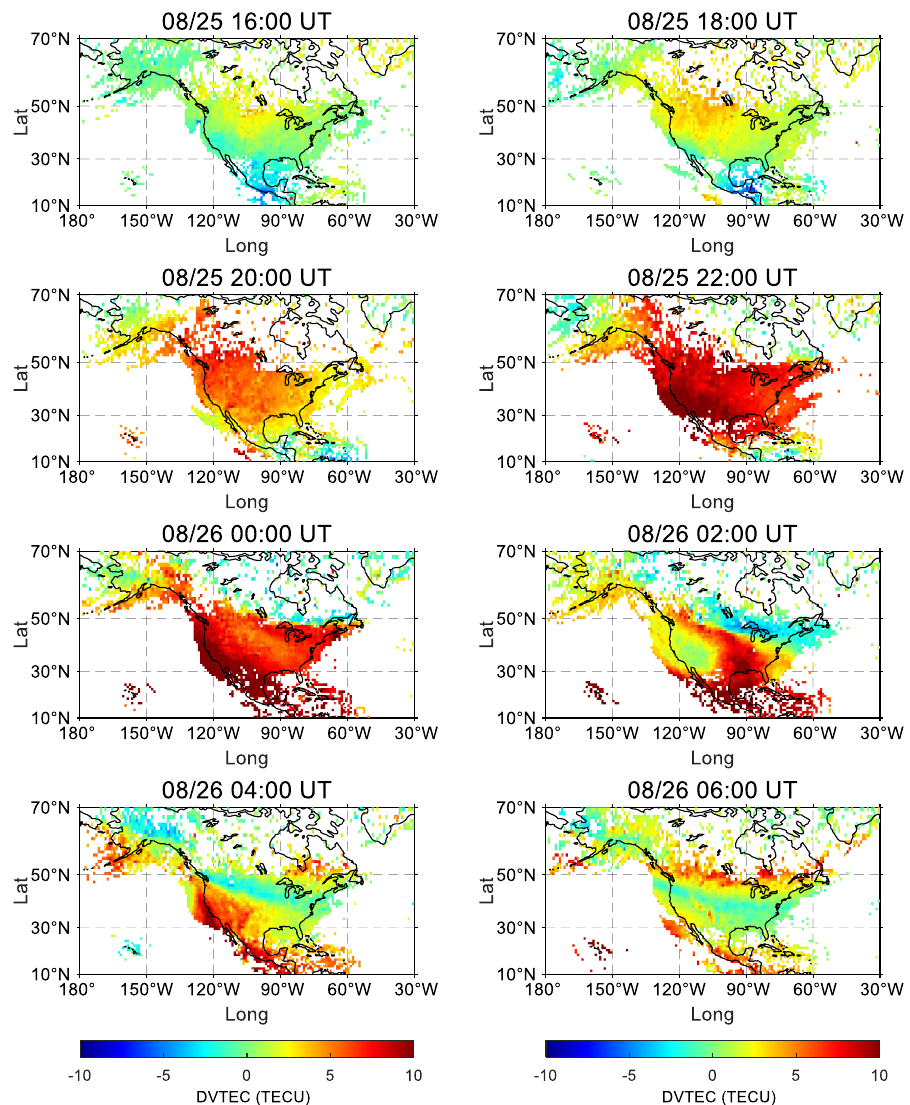
Figure 3. Spatiotemporal evolutions of the North American positive ionospheric storm. To investigate the latitudinal and temporal variations of storm-1, the latitude/time variation of VTEC difference and relative VTEC difference at 110° W from 15° N to 60° N are given in Figure 4. As we can see in Figure 4a, the VTEC enhancement started from 60°